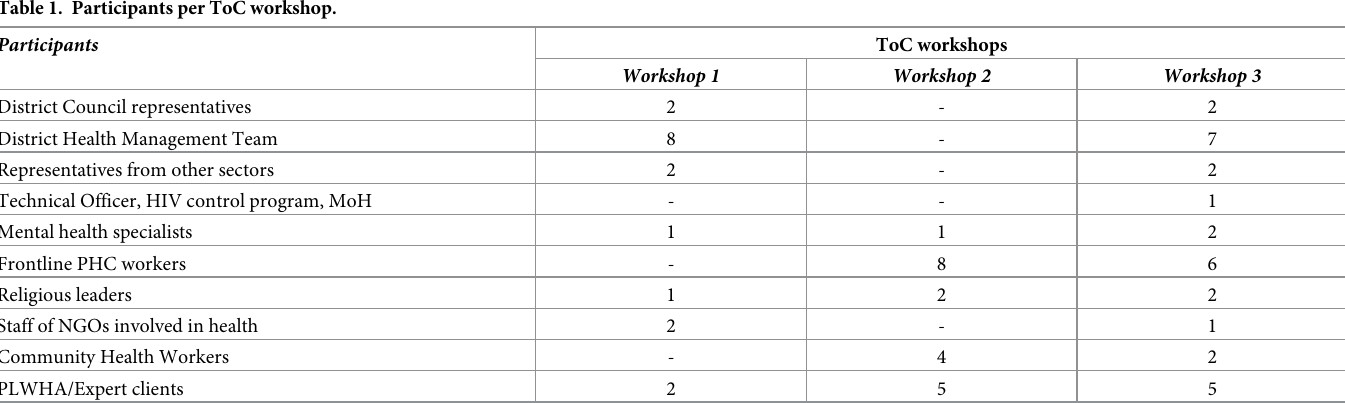
Table 1. Participants per ToC